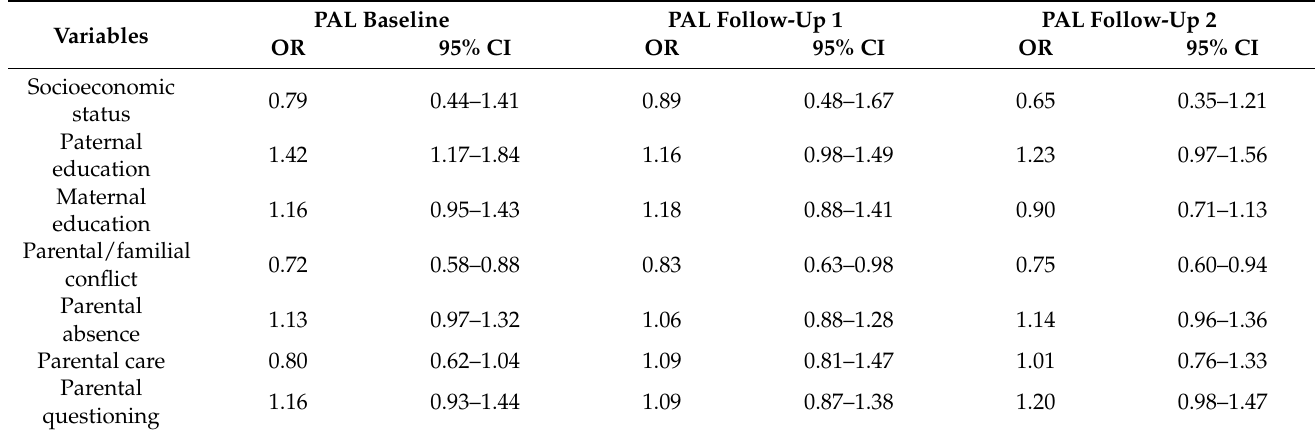
Table 2. Correlates of physical activity levels at baseline, and two follow-up measurements; results of the logistic regression analysis controlled for gender and sport participation as covariates (N =